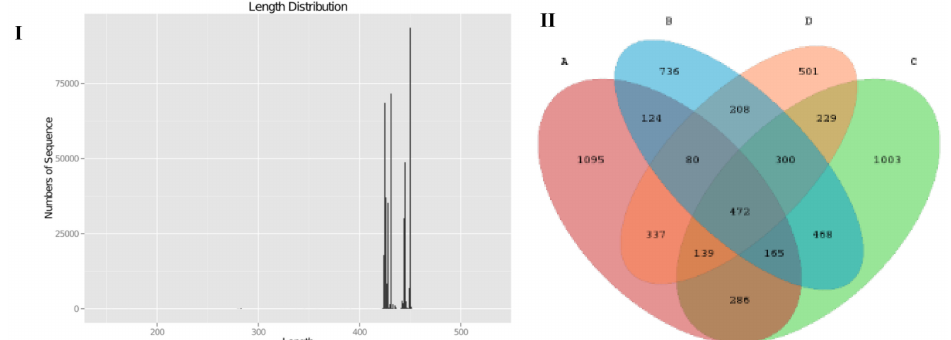
Figure 5. DNA raw data and comparison of the OTUs in all examined colon contents. I: DNA sequencing number and length; II: Venn diagram for describing the common and unique OTUs. A: LFD; B: HFD; C: HFD + LE; D: HFD + HE. Different lower-case letters correspond to